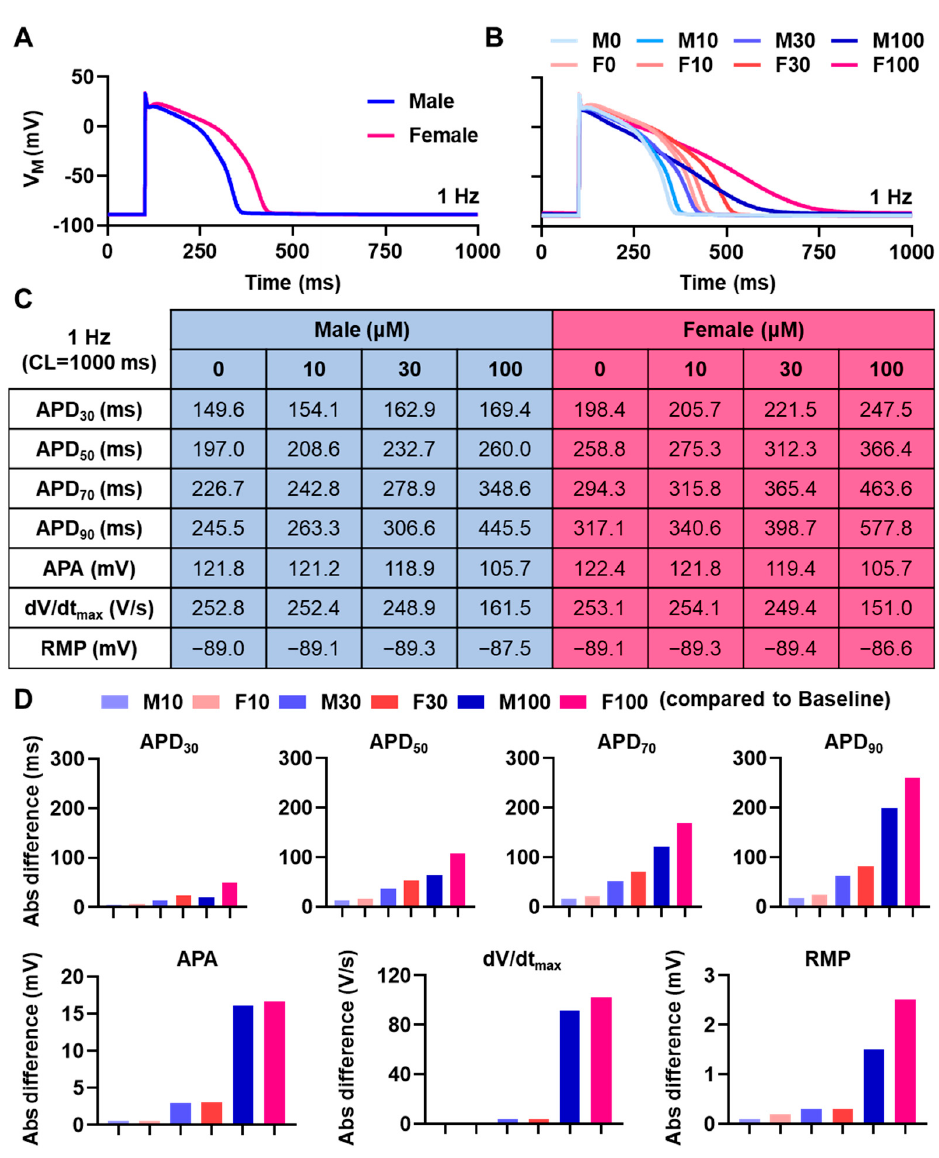
Figure 2. Sex-dependent effect of naringenin on the action potential of ventricular cardiomyocytes. ( A ) The comparison of male and female action potentials of ventricular endocardium. ( B – D ) The concentration-dependent effect of naringenin on male and female ventricular action potentials. The baseline/no-compound conditions (M0 and F0) were used to calculate the absolute (Abs) difference in ( D ). All simulations were performed in 1 Hz pacing frequency. (APA = action potential amplitude; APD = action potential duration; CL = cycle length; F0 = Female 0 μ M; F10 = Female 10 μ M; F30 = Female 30 μ M; F100 = Female 100 μ M; M0 = Male 0 μ M; M10 = Male 10 μ M; M30 = Male 30 μ M; M100 = Male 100 μ M; RMP = resting membrane potential).